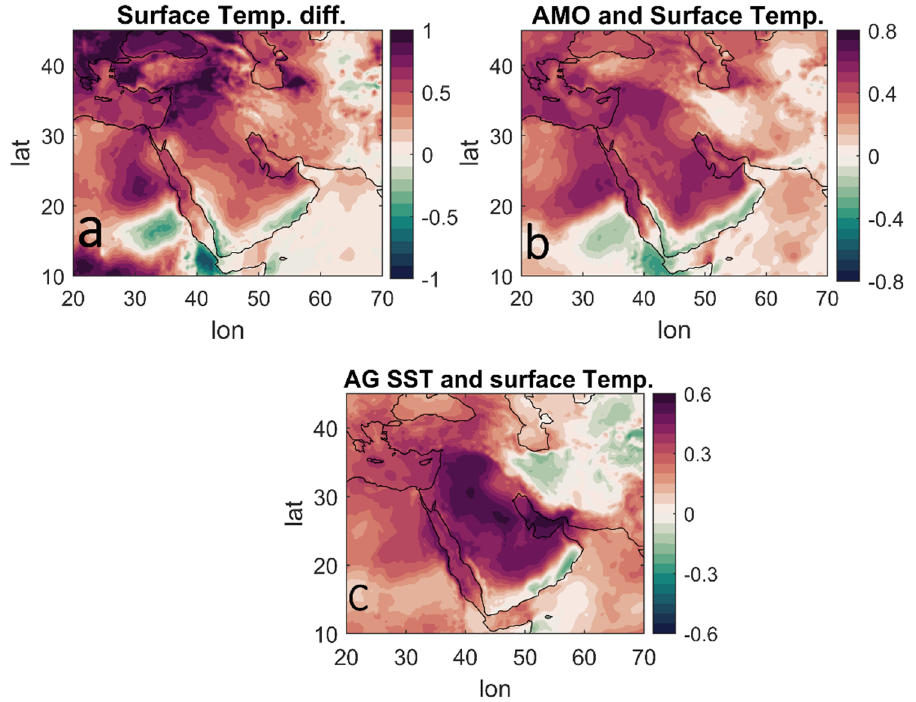
Figure 8. Same as Figure 7, but for the surface temperate.